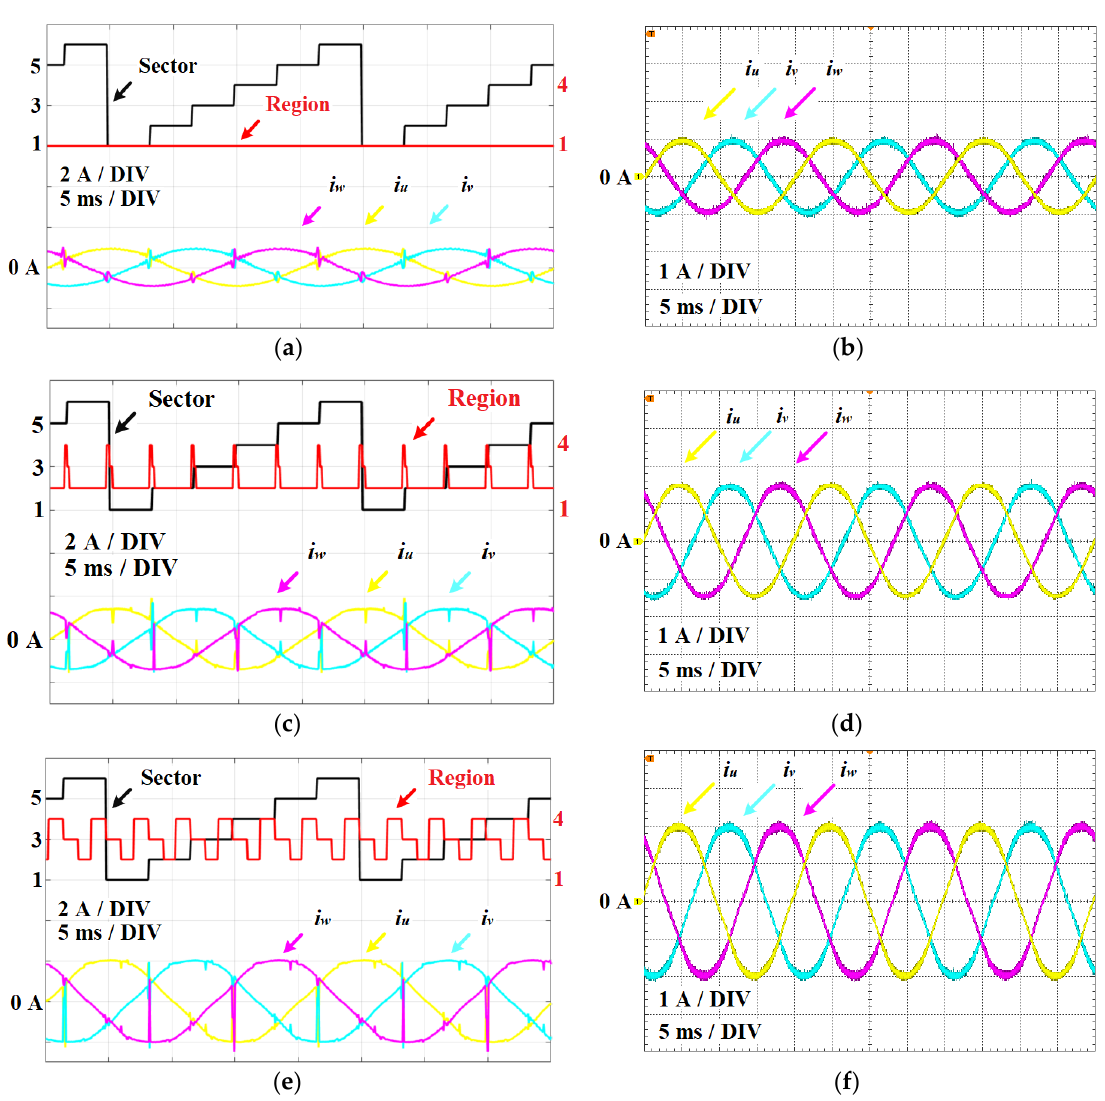
Figure 19. Single-shunt reconstruction of a three-phase current without SVM modification for f = 50 Hz: ( a ) m i = 0.4; ( c ) m i = 0.6; ( e ) m i = 0.8; scope-measured real three-phase currents for f = 50 Hz : ( b ) m i = 0.4; ( d ) m i = 0.6; ( f ) m i = 0.8.